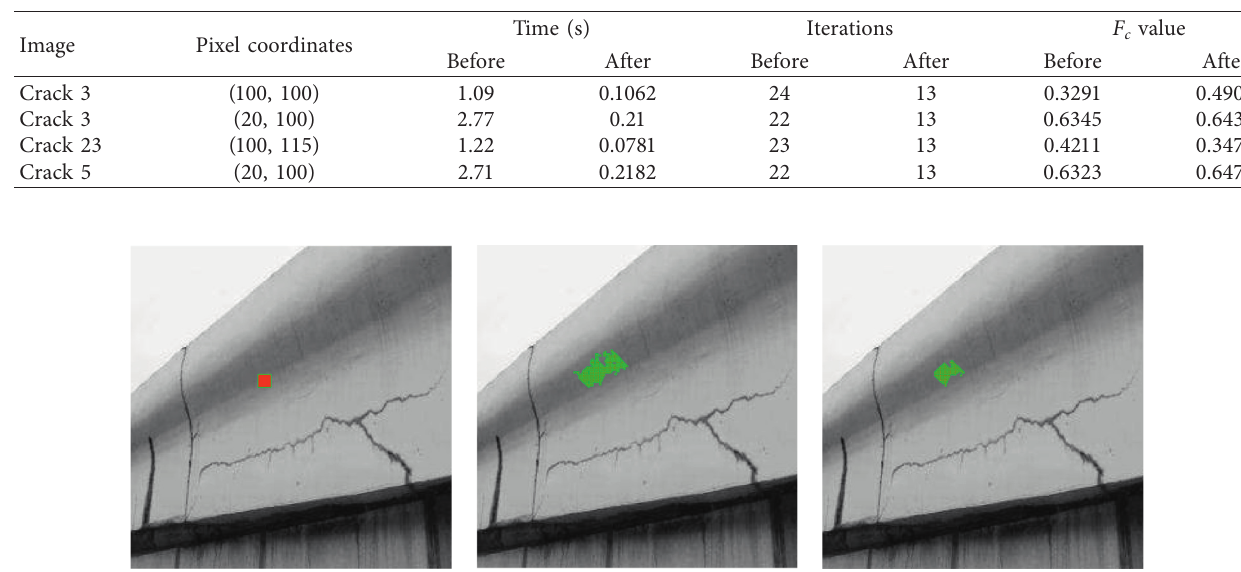
Table 2: The performance of the conditional termination strategy.